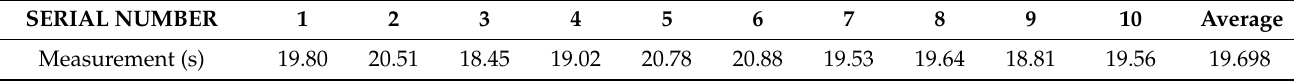
Figure 19. The velocity curve of the sphere. The x-axis represents time, and the y-axis denotes the size of the garbage combined velocity. It takes 18.68 s for the sphere to stabilize. Table 6. Time taken for the spherical waste to stabilize at the identification platform.